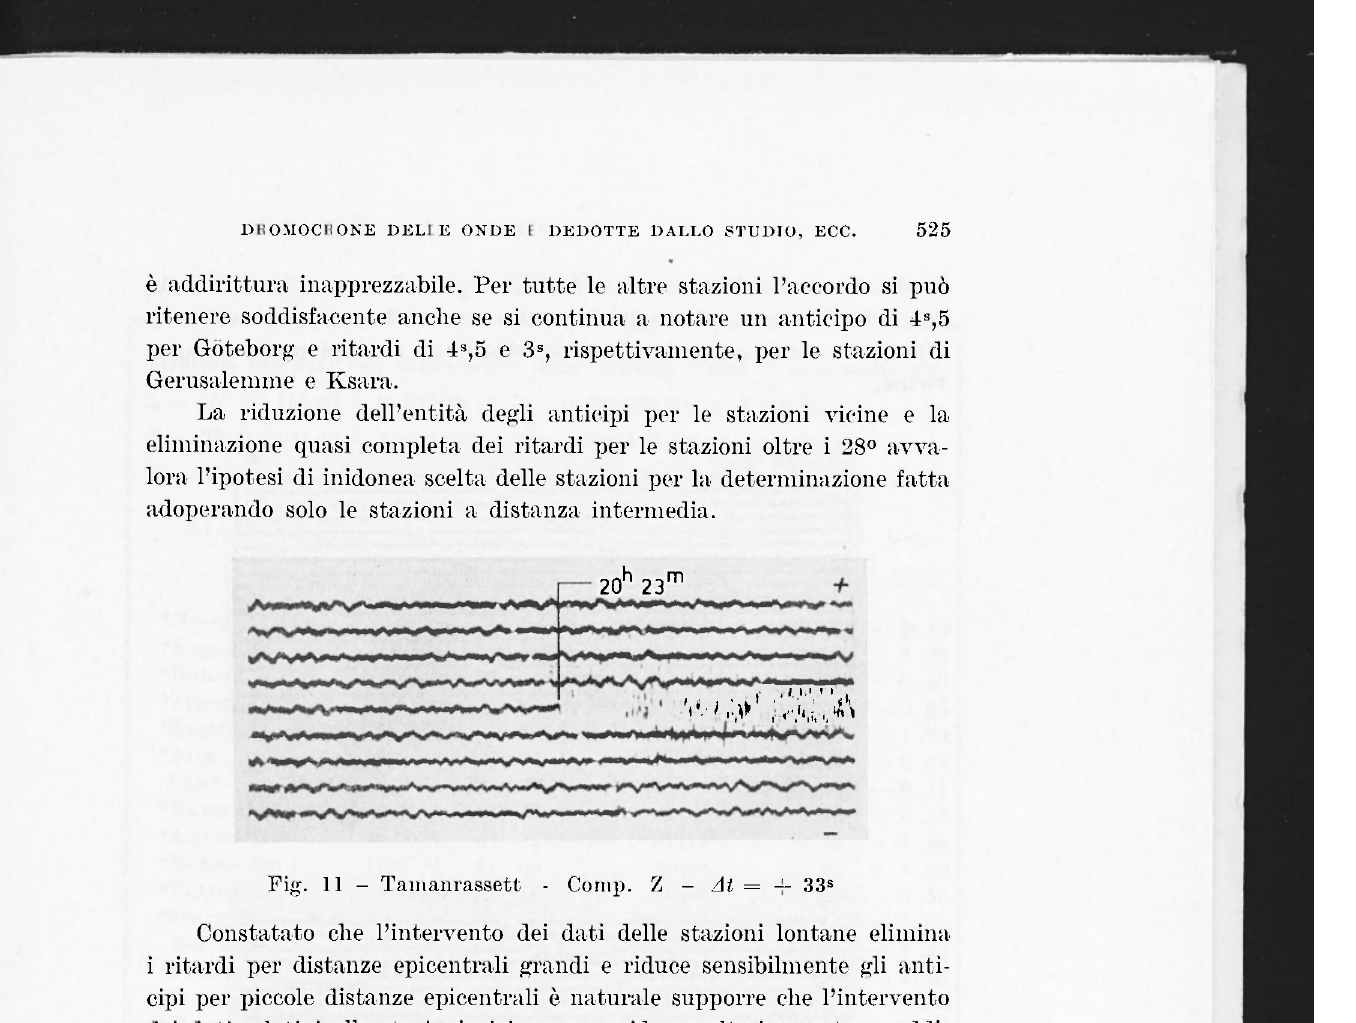
Fig. 11 - Tamanrassett - Comp. Z - At = + 33